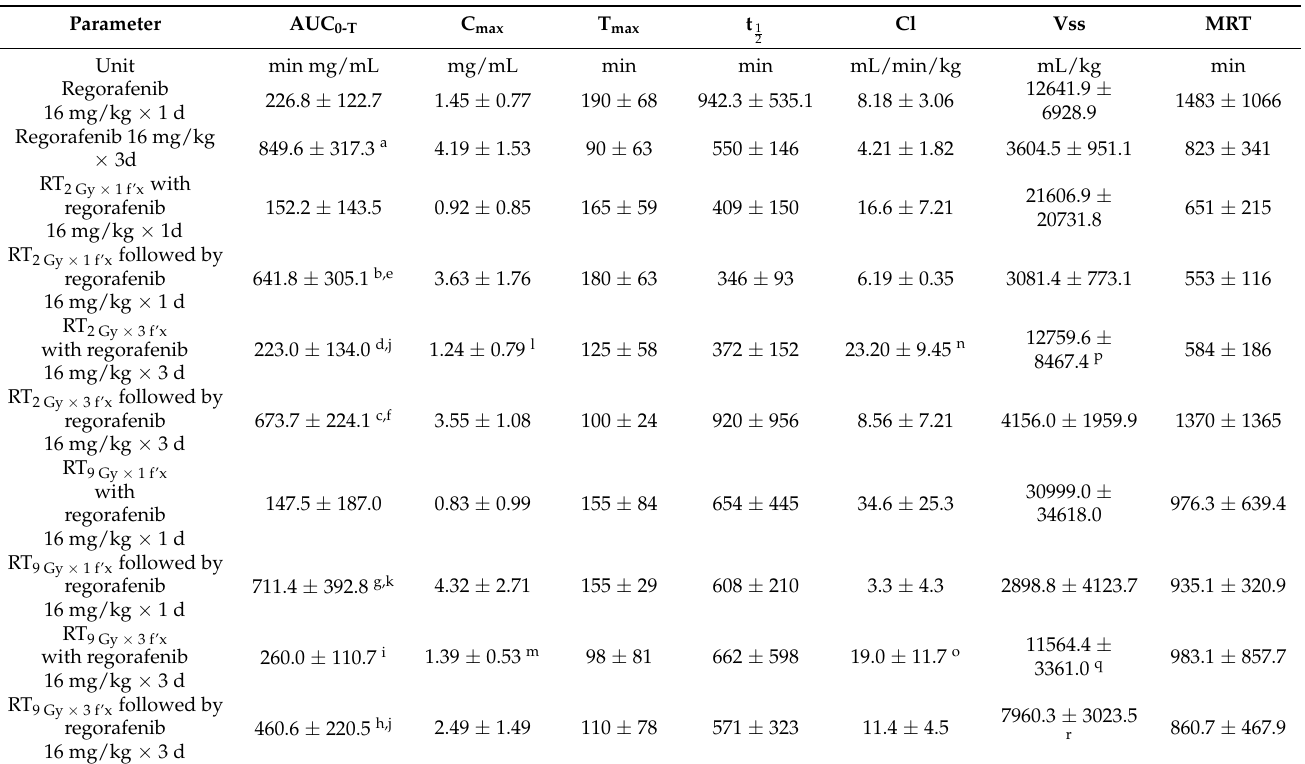
Table 1. Pharmacokinetic parameters of regorafenib (16 mg/kg, p.o.) with and without RT 2 and 9 Gy.